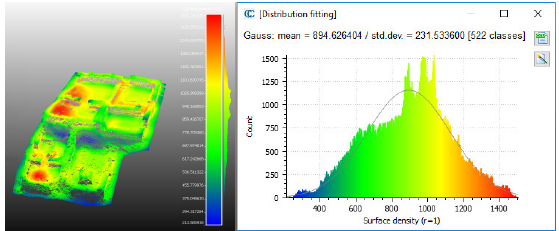
Figure 9a. Density analysis of the project 1 (the two nadiral acquisitions) – Sample A